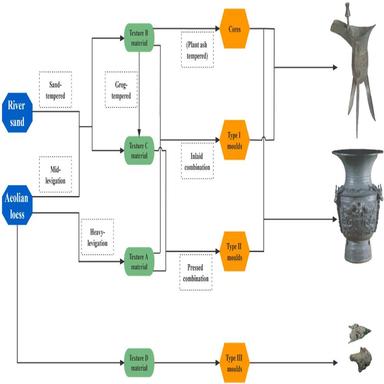
The reconstructed material choice strategy of the moulds and cores made at the Taijiasi site.